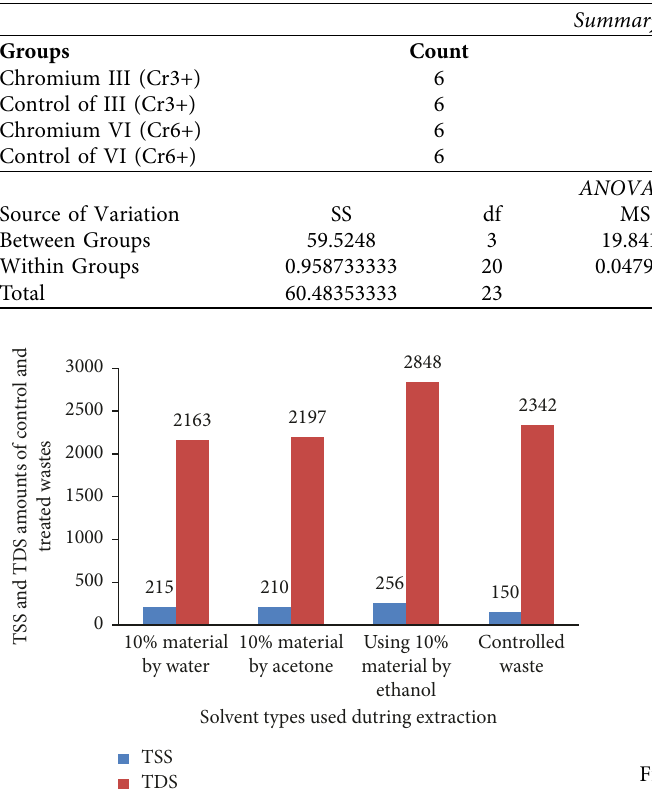
Figure 6: TDS and TSS values of controlled and treated wastes by using leaf 10% materials extracted by different extraction solvents.